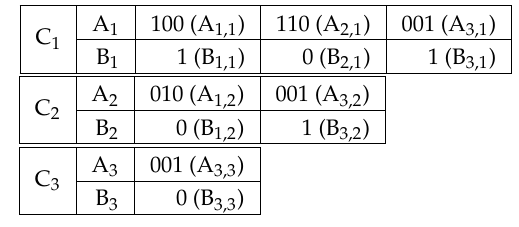
Figure 8. Organization of 3 Directly Addressable Codes (DACs)